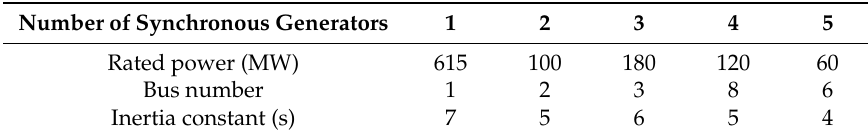
Figure 5. IEEE 14-bus system. Table 2. Parameters of synchronous generators.